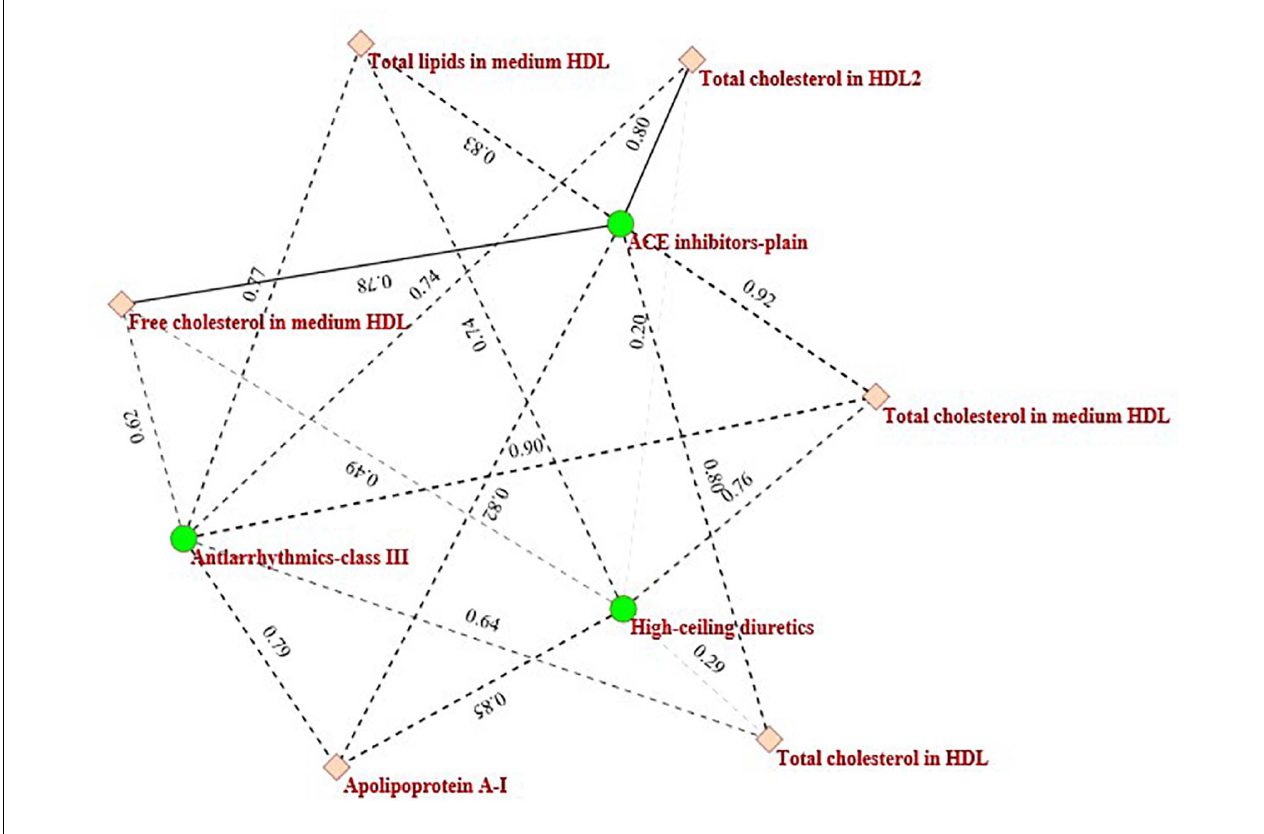
FIGURE 5 | The sub-network consists of three drugs and six metabolites.